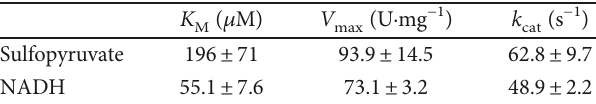
Table 1: Kinetic parameters for ComC, for sulfopyruvate, and for NADH. Standard assay conditions in the reduction reaction were used; 400 mM KCl, pH 6.5, and 37 ° C. Assays were carried out in triplicate. One unit of activity (U) is de fi ned as the conversion of one μ mol of NADH to NAD + per minute under standard assay conditions.